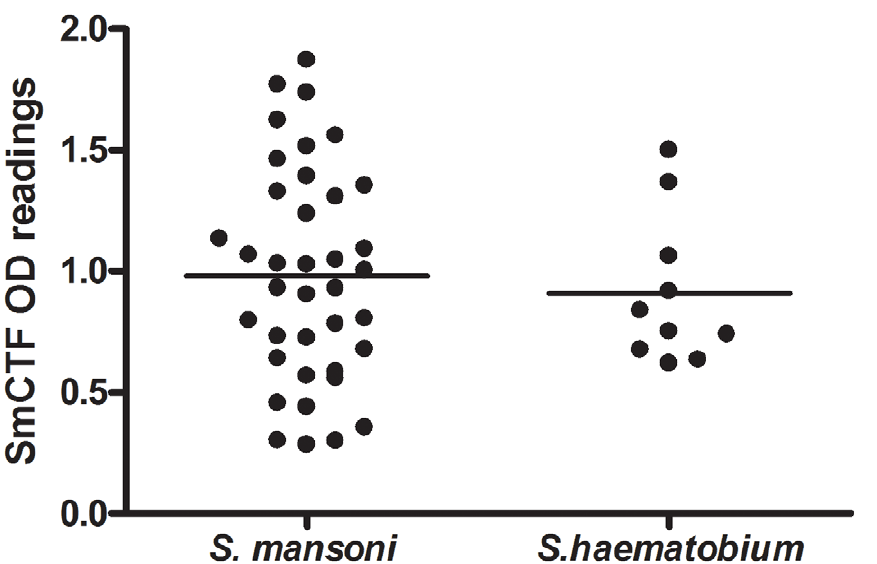
Figure 4. SPDRL: comparison of S.mansoni - and S.haematobium -infection sera in ELISA. Graph of the greater-than-cut-off OD450 results of S. mansoni infection sera in Figure 1 and S. haematobium infection sera in Figure 2 reacting against S. mansoni cercarial transformation fluid (SmCTF). Horizontal lines indicate the mean SmCTF OD450 values for each group of sera.